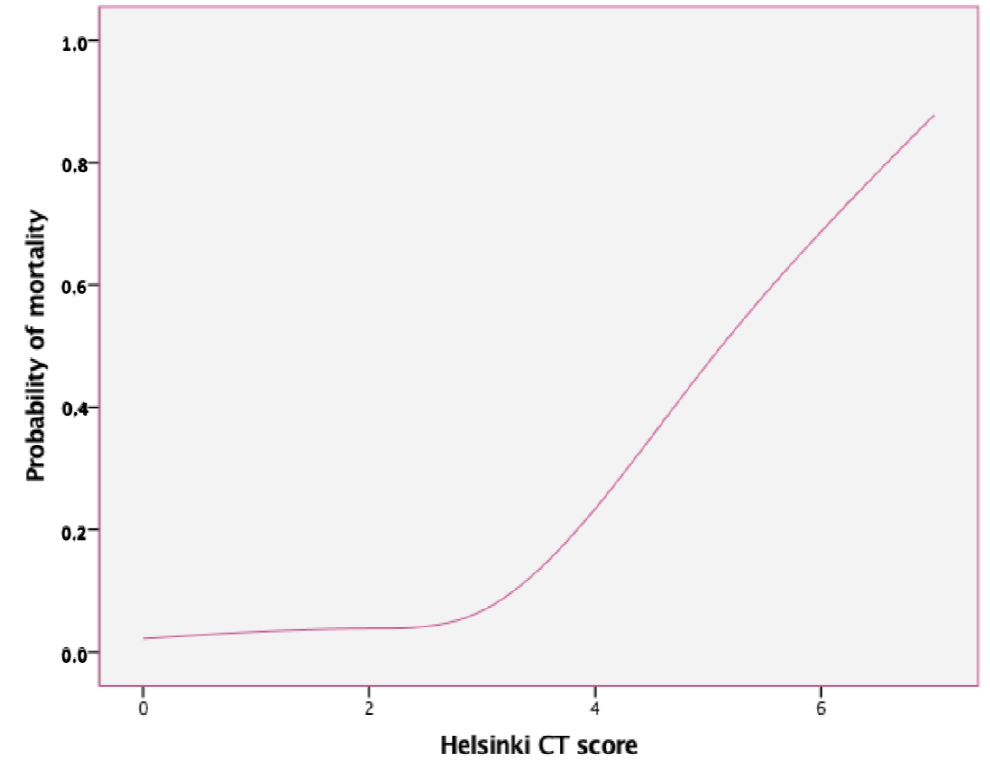
Figure 4. Prediction of mortality through Helsinki CT score. Mortality rates in sTBI patients reached 10.2%, while three preschoolers (2.5%) who